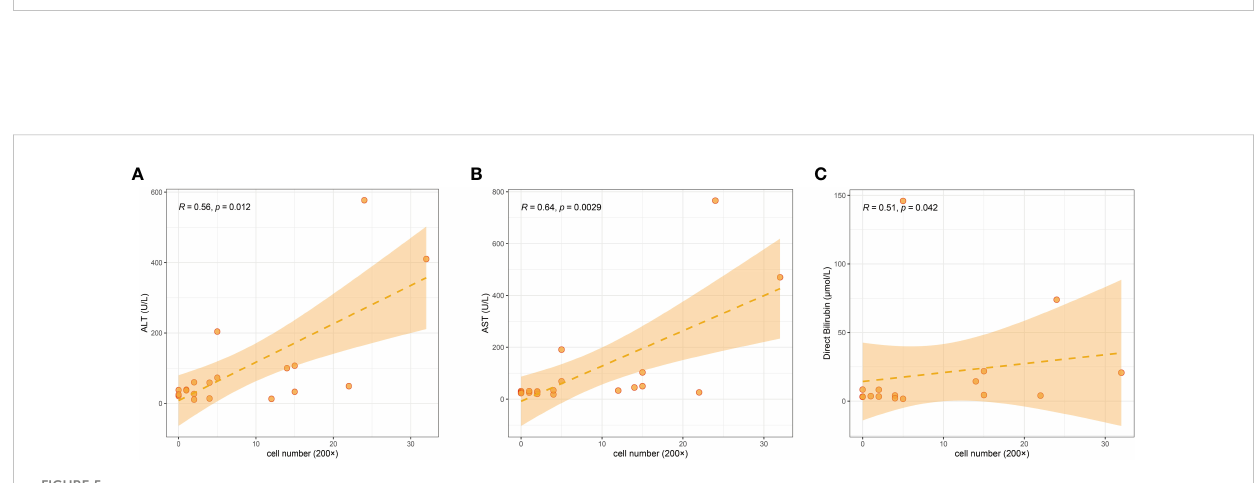
FIGURE 5 Correlation among numbers of LAMP3+ cells in liver section with serum markers of liver dysfunction in patients with CHB. (A) ALT, (B) AST, (C) DBIL. ALT, alanine aminotransferase; AST, aspartate aminotransferase; DBIL, direct bilirubin; CHB, chronic hepatitis